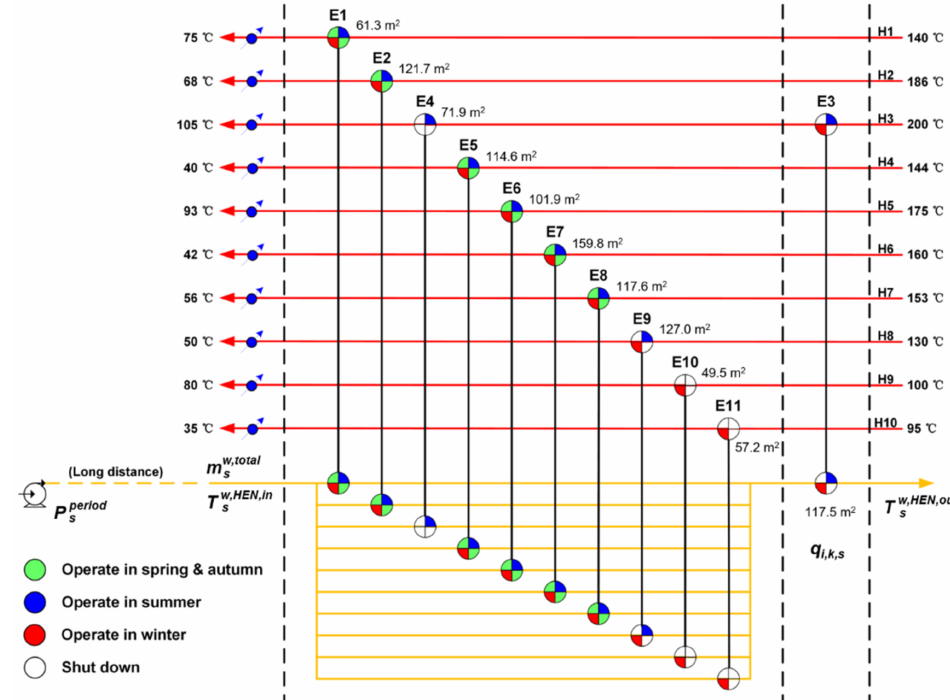
Figure 6. The HEN of the third step.